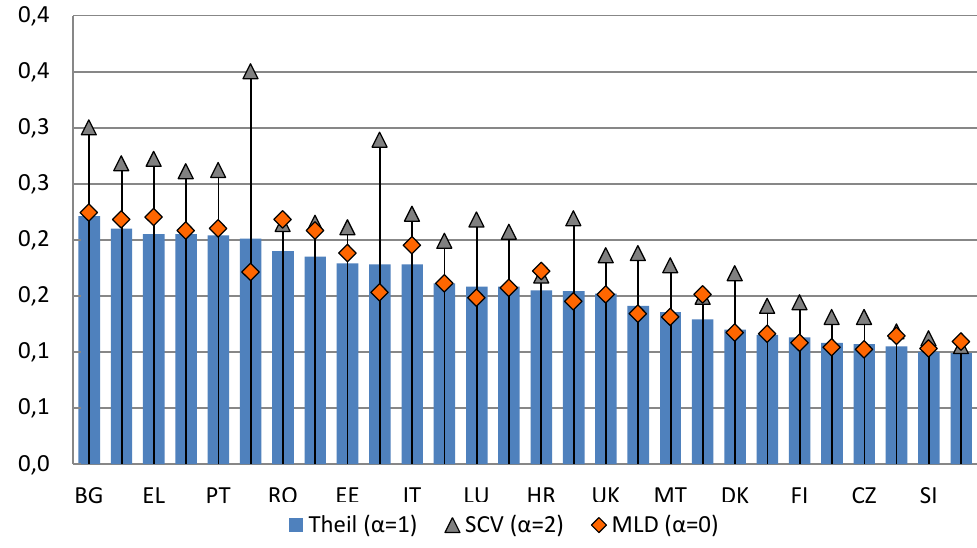
Figure 9 . Generalized entropy measures for the EU-28 countries, 2012. Source: Own elaboration based on statistics from the European Commission. Note: Countries appear ranked according to the highest Theil